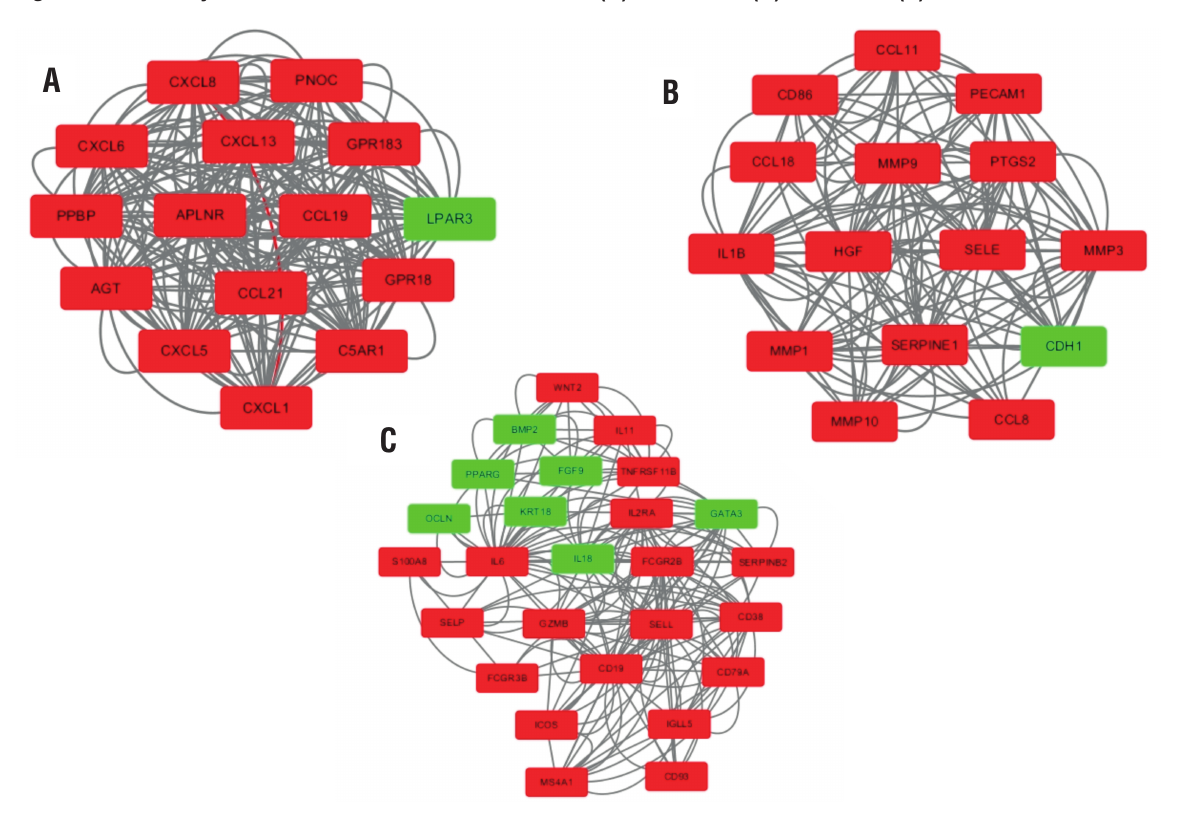
Figure 4 - The key modules of PPI network. Module1(a), Module 2(b),